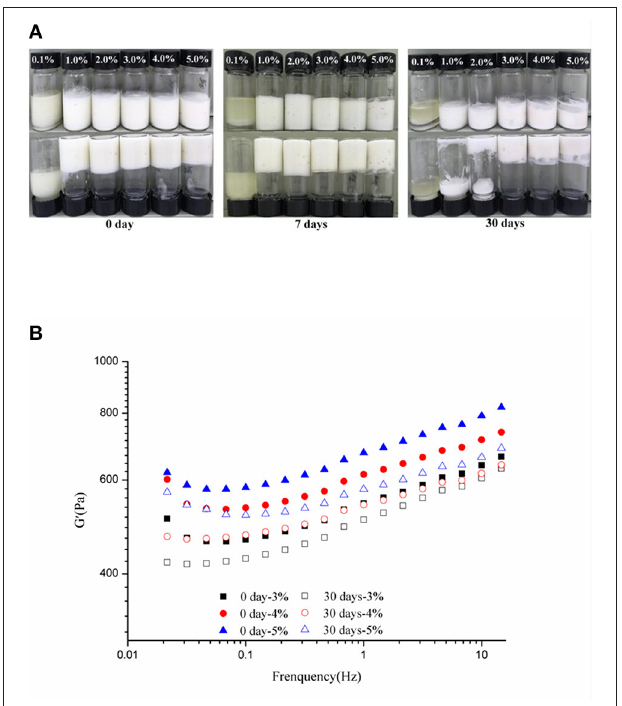
FIGURE 7 | Visual appearance (A) and frequency sweeps (B) of the WSP-stabilized HIPEs as unheated, heated at 40, 60, 80, and 100 ◦ C, respectively.